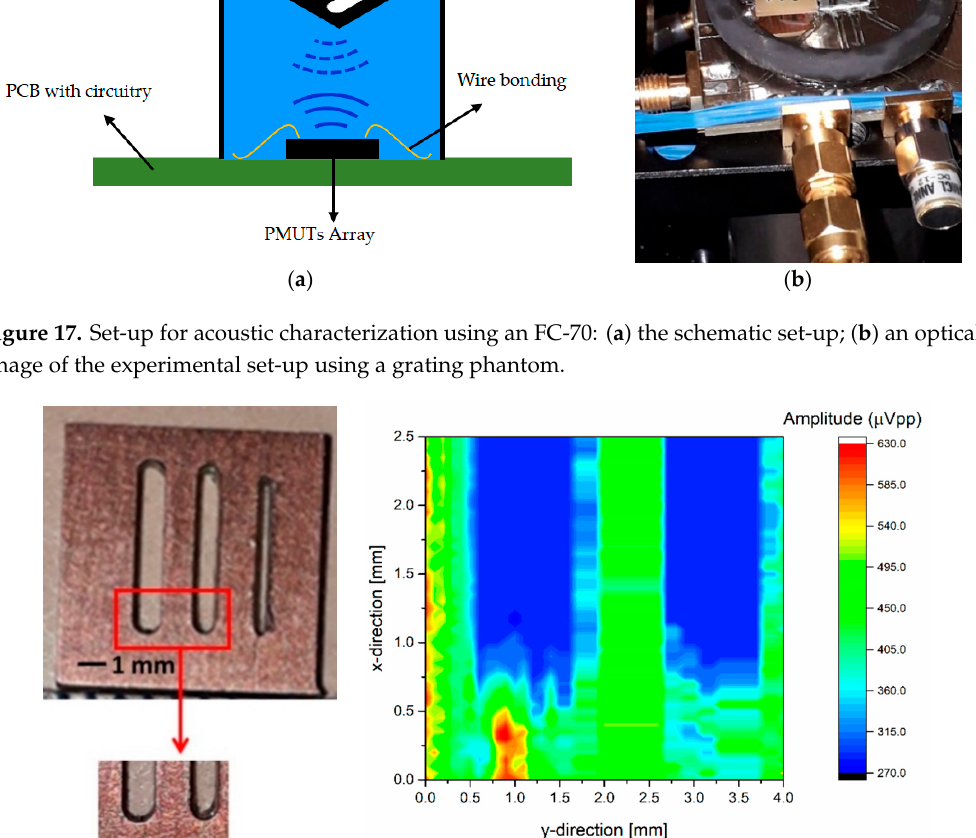
Figure 18. ( a ) Grating phantom and ( b ) an ultrasonic image of a phantom section.